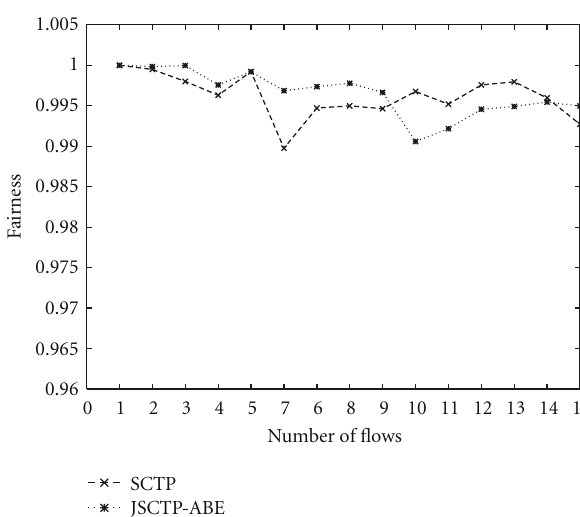
Figure 12: One way propagation delay from 10 ∼ 100ms with 1% loss.